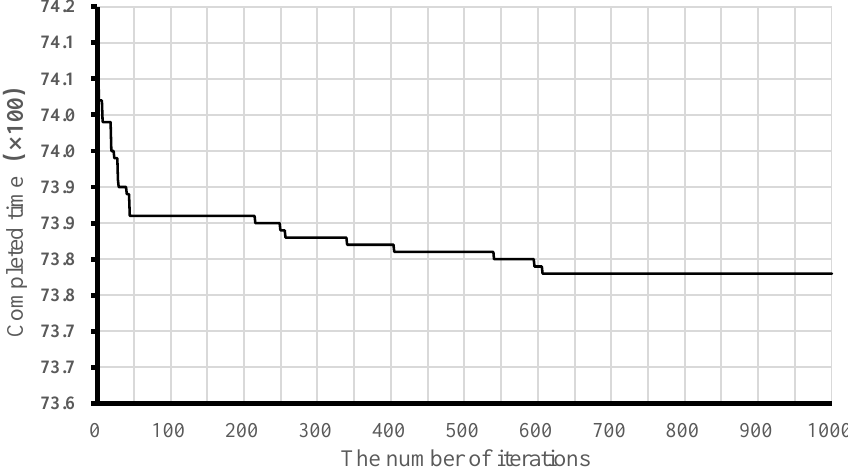
Figure 19. Optimal solution of each generation in the iteration process of the genetic algorithm (GA).